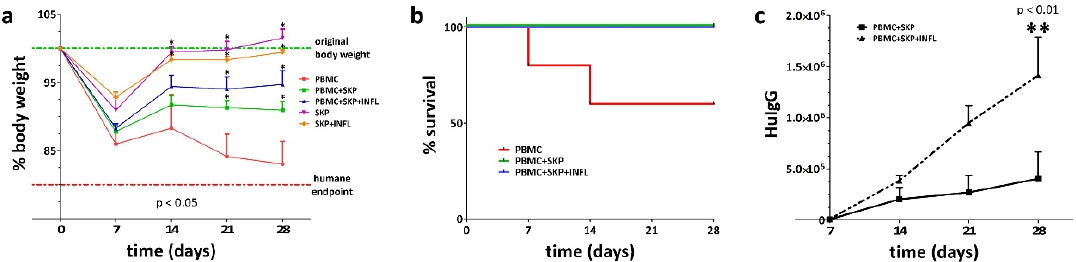
Figure 5. Pro-inflammatory stimulation of SKP alters, to some extent, their immune suppressive properties. ( a , b ) Unstimulated and pro-inflammatory stimulated SKP both suppress the graft-versus- host response of cotransplanted human PBMC in SCID mice. However, ( c ) cotransplantation of PBMC with pro-inflammatory stimulated SKP results in significantly higher human IgG blood levels compared to cotransplantation with unstimulated SKP, suggesting a lower in vivo immune suppressive capacity of SKP+INFL. * Significantly increased versus PBMC ( p -value < 0.05); ** Significantly increased versus PBMC+SKP ( p -value <